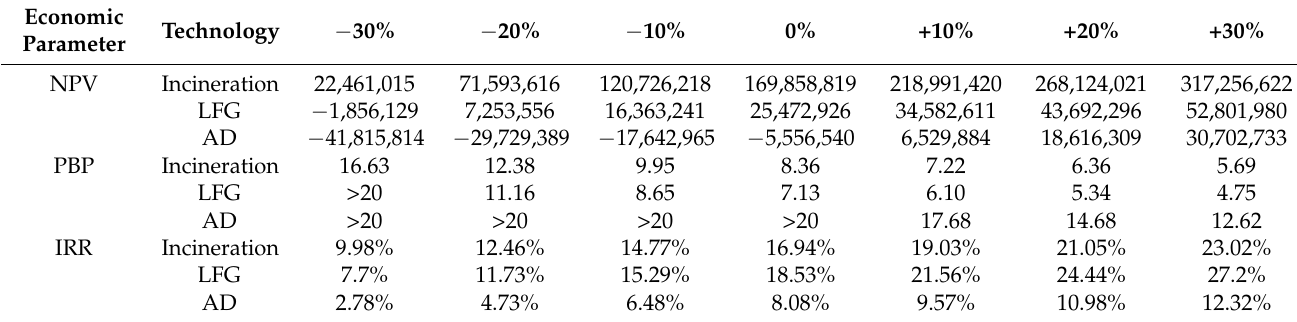
Table 9. Influence of feed-in tariff on NPV, PBP, and